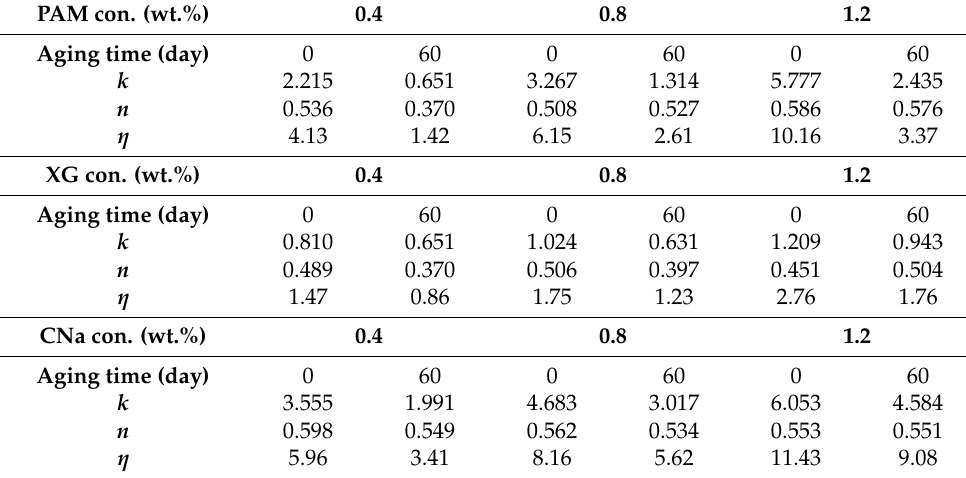
Table 1. Fluid parameters of polymer solution before and after self-aging. PAM con. (wt.%) 0.4 0.8 1.2